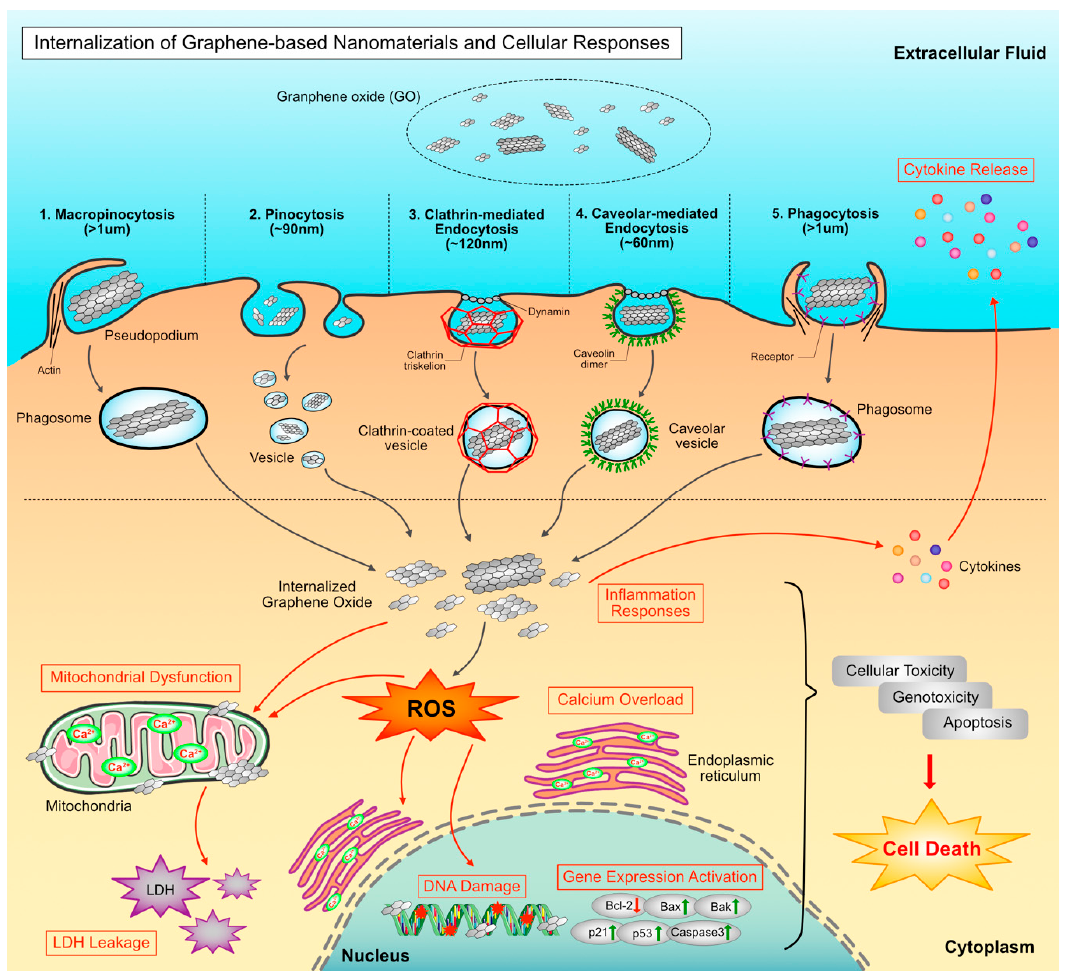
Figure 10. Proposed model for ROS- mediated cellular toxicity and signaling in TM3 and TM4 cell.